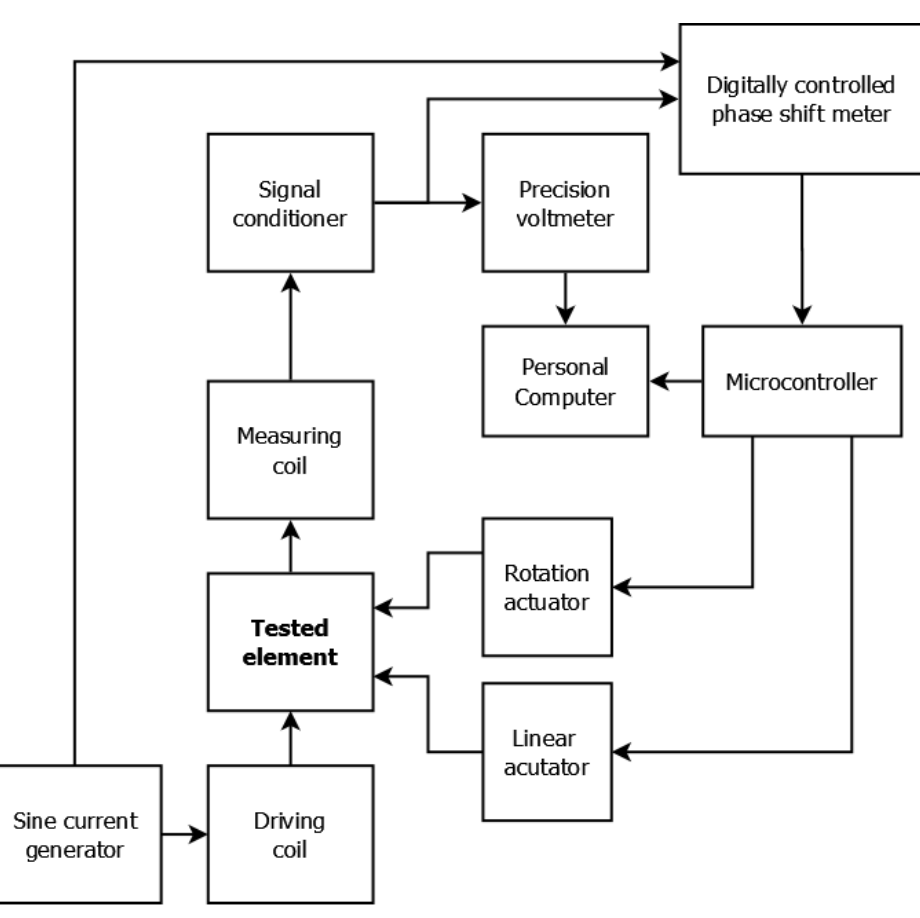
Figure 2. Block diagram of the utilized eddy current tomography setup.